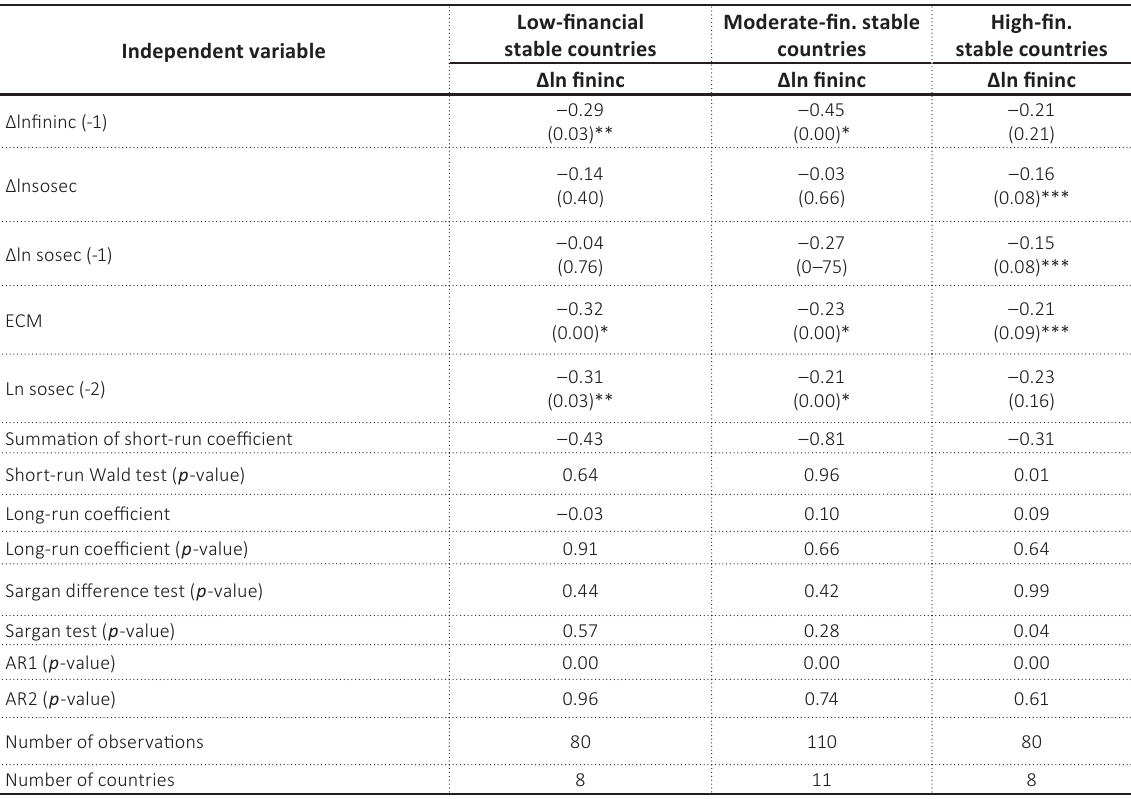
Table 3. Seclusion-inclusion nexus from 2007 to 2017. Dependent